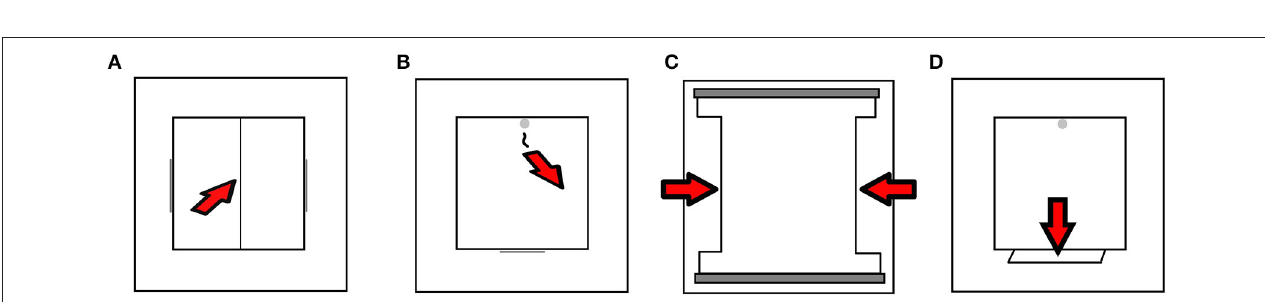
FIGURE 1 | (A) Schematic drawing of the Test Battery Apparatus (TBA) on its platform without inserted panels in the open frames of the sides S1 (left), S2 (back), and S3 (right). (B) Photo of TBA from the opposite side. The open frame of S2 can be seen on the front, the frames of S1 and S3 are on the right and left side, respectively. The far side and top are permanently covered with transparent acrylic glass.